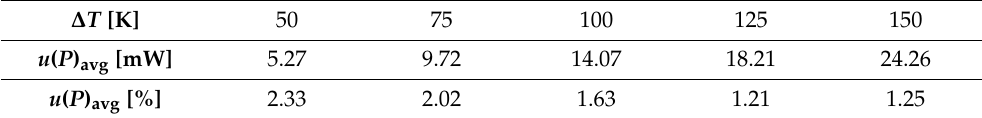
Figure 4. Power output P of TEM3, measured at DLR (Lab 3a/3b) in dependence on current flow I for Δ T = 125 K at open-loop conditions. P ( I , t ) represents raw data for nominally stable boundary conditions. P ( I ) Mean is calculated as an average of P ( I , t ) for each current value. The shown error bar of P ( I ) Mean corresponds to the uncertainty u ( P ( I , t )) ( k = 1) according to Equation (9). Both P ( I , t ) and P ( I ) Mean are input to parabolic approximations (dashed lines). The inset indicates the maximum power points determined from approximations of P ( I , t ) (open red triangle) and P ( I ) Mean (open black triangle). Error bars of both maximum power points correspond to uncertainties u ( P max ) ( k = 1) according to Equation (23). Table 3. The average uncertainty u ( P ) avg is calculated as a mean value from uncertainties of power measurements u ( P ) ( k = 2) at individual current set points. The average uncertainty u ( P ) avg is given by absolute and relative values in dependence on the applied ∆ T